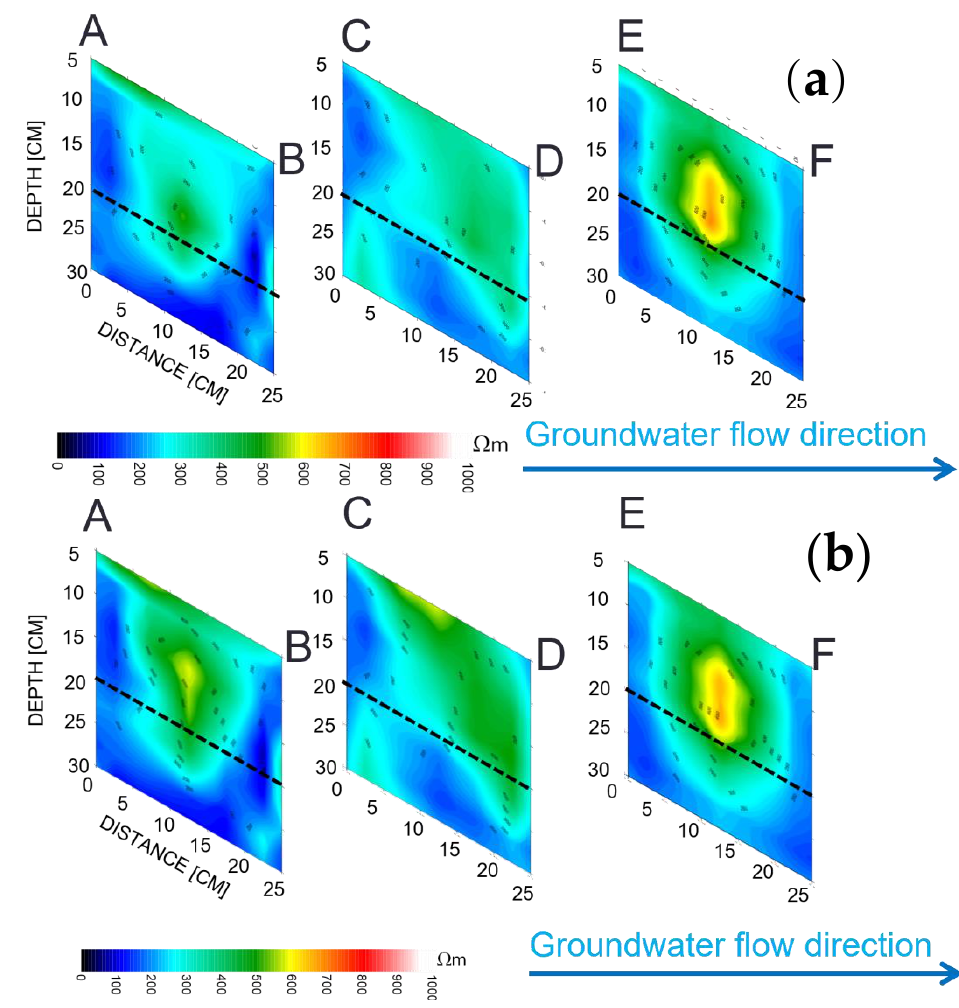
Figure 2. Resistivity maps acquired in uncontaminated conditions ( a ) and after 12 h from the contamination ( b ). The sections describe the resistivity behavior measured with CHERTs between the three sections enclosed between the three couples of geoelectrical